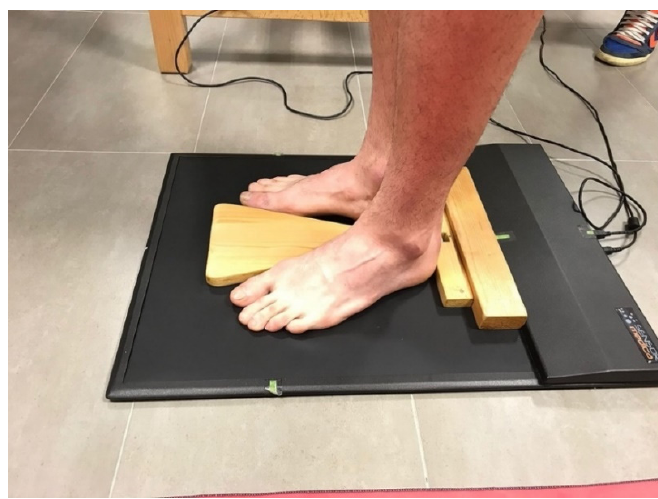
Figure 1. Wooden spacer for position